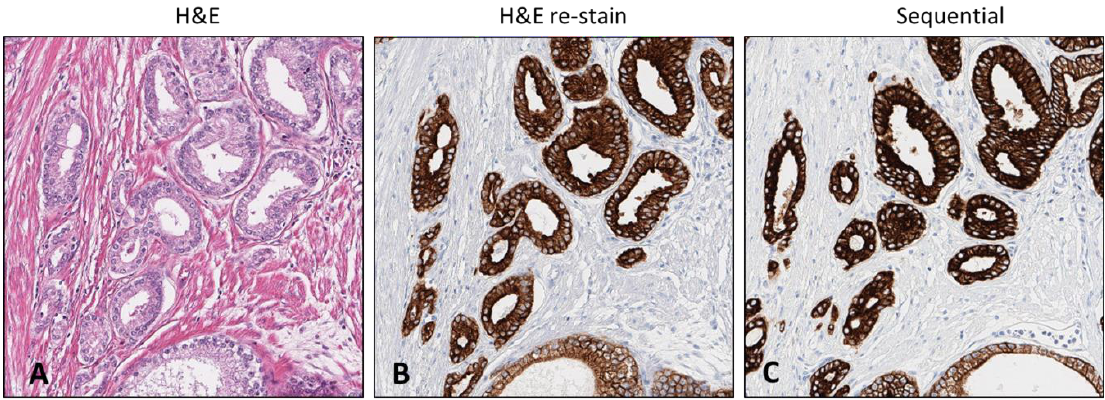
Figure 6. The H&E stained slide archived 4 + years subjected to de-stain and re-stain procedure compared to the sequential sample slide. Initial H&E stained slide containing region of tumor ( A ). CK